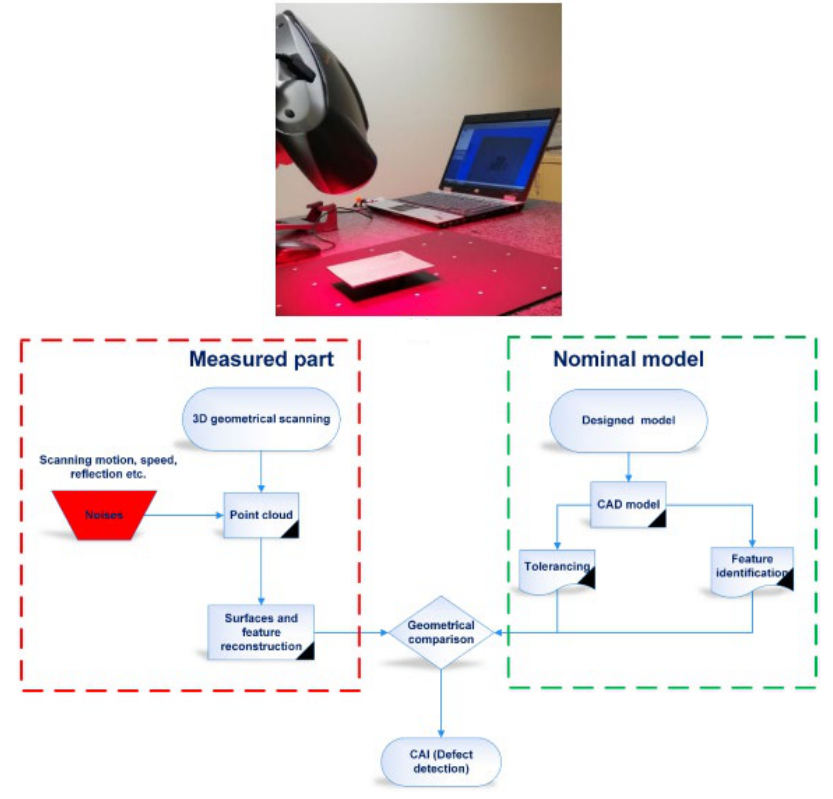
Figure 14. 3D laser-scanning Inspection